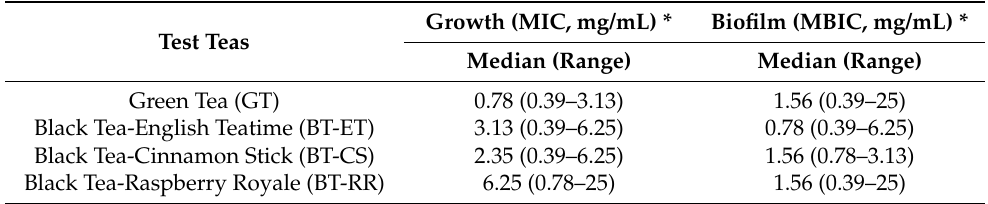
Table 1. Inhibition of growth and biofilm formation of children’s supragingival plaque bacteria by teas ( n = 16).